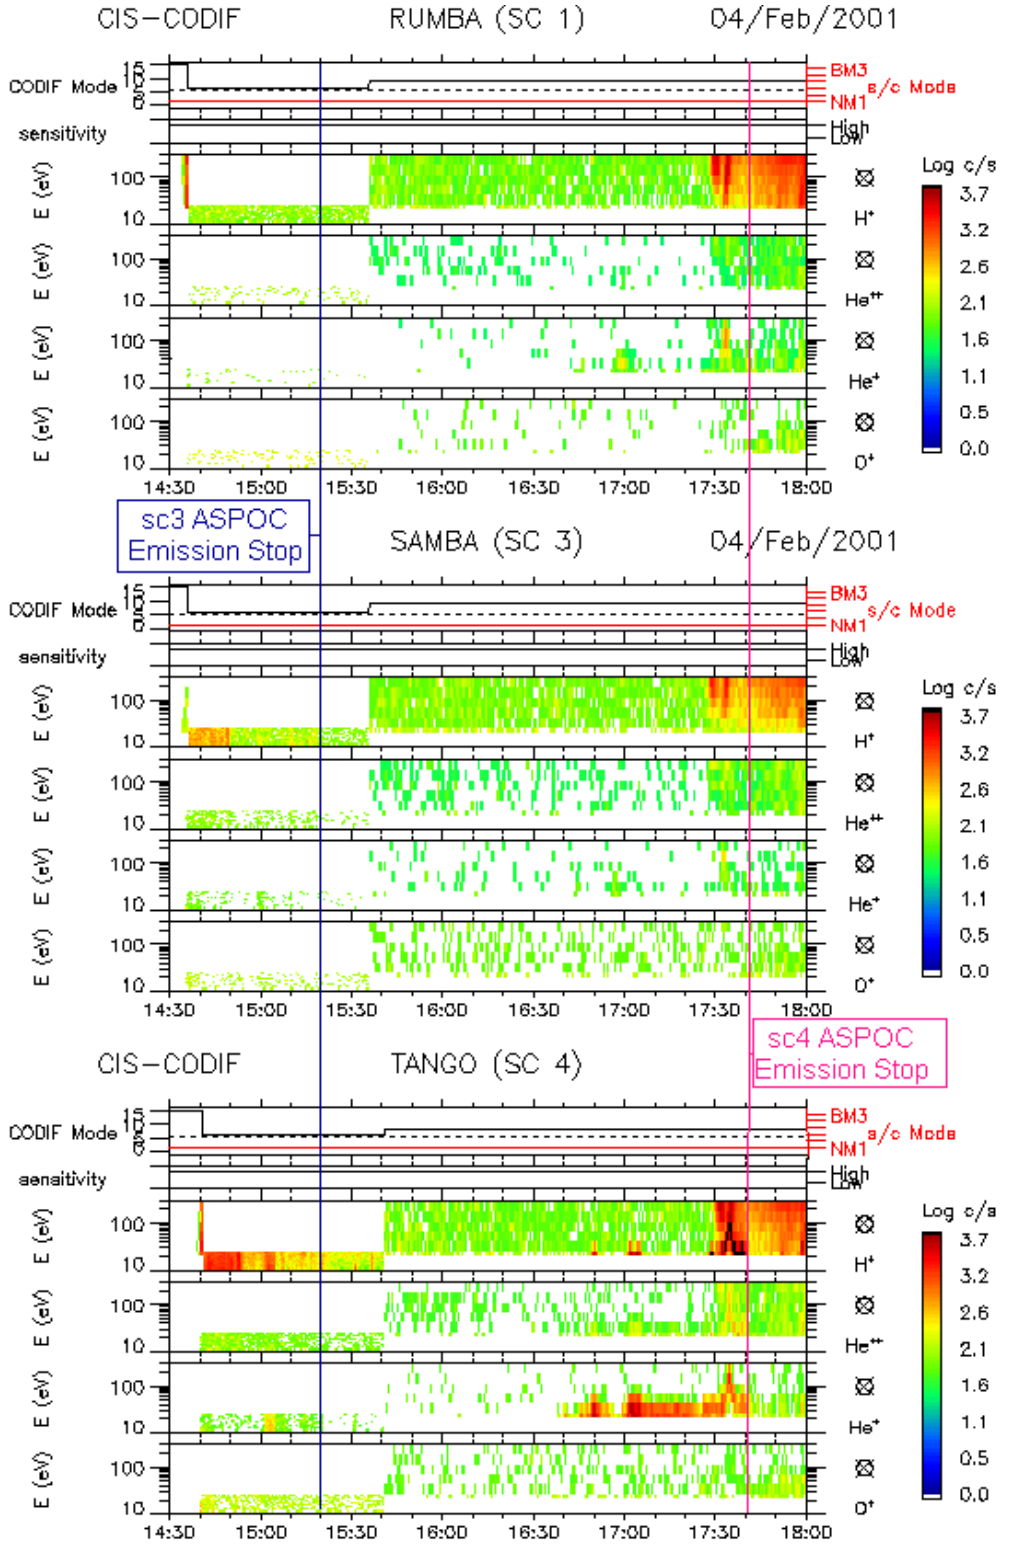
Fig. 41. Effect on ASPOC for low energy ion measurements, on 4 February 2001: CODIF energy-time spectrograms, integrated over 4 5 , for H + , He ++ , He + , and O + ions on spacecraft 1, 3, and 4 are shown. On spacecraft 1 ASPOC does not work; on spacecraft 3 ASPOC stops at 15:20UT; on spacecraft 4, ASPOC stops at